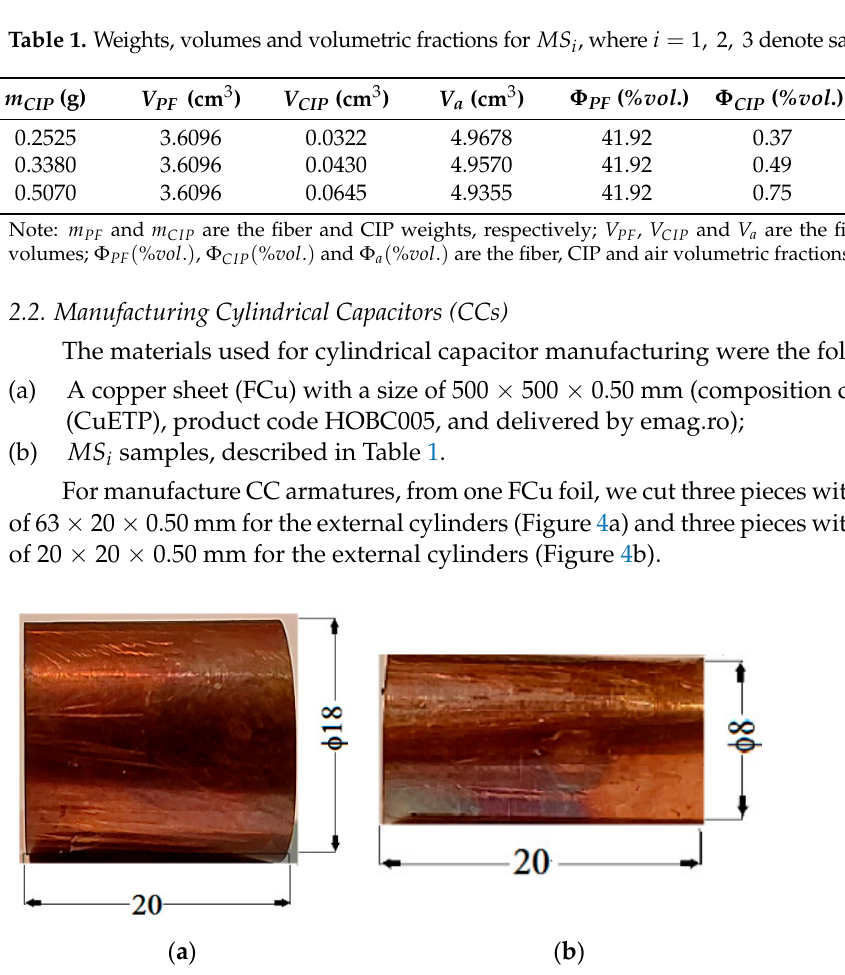
Figure 4. The copper armatures of the DC capacitors: ( a ) outer cylinder; ( b ) inner cylinder. Each MS sample was forcibly inserted between the copper armatures, achieving the overall configuration shown in Figure 5a. At the end of this process, the CCs from Figure 5b were obtained.